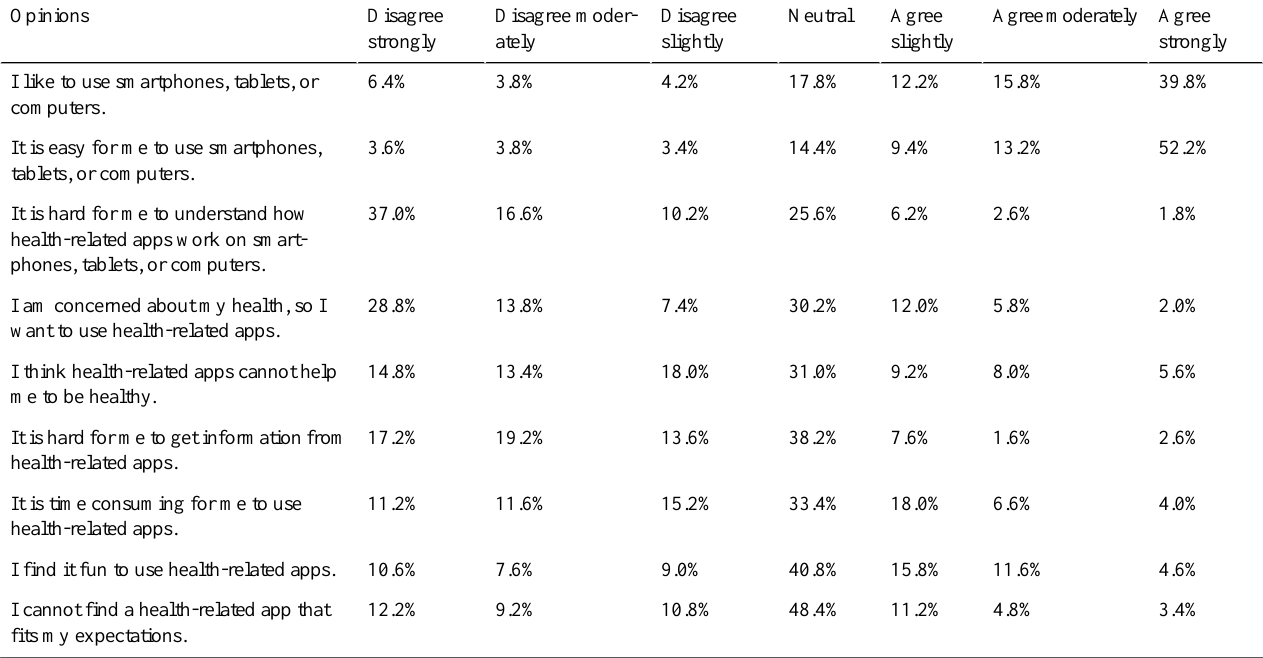
Agree stronglyAgree moderatelyAgree slightlyNeutralDisagree slightlyDisagree moder- atelyDisagree stronglyOpinions